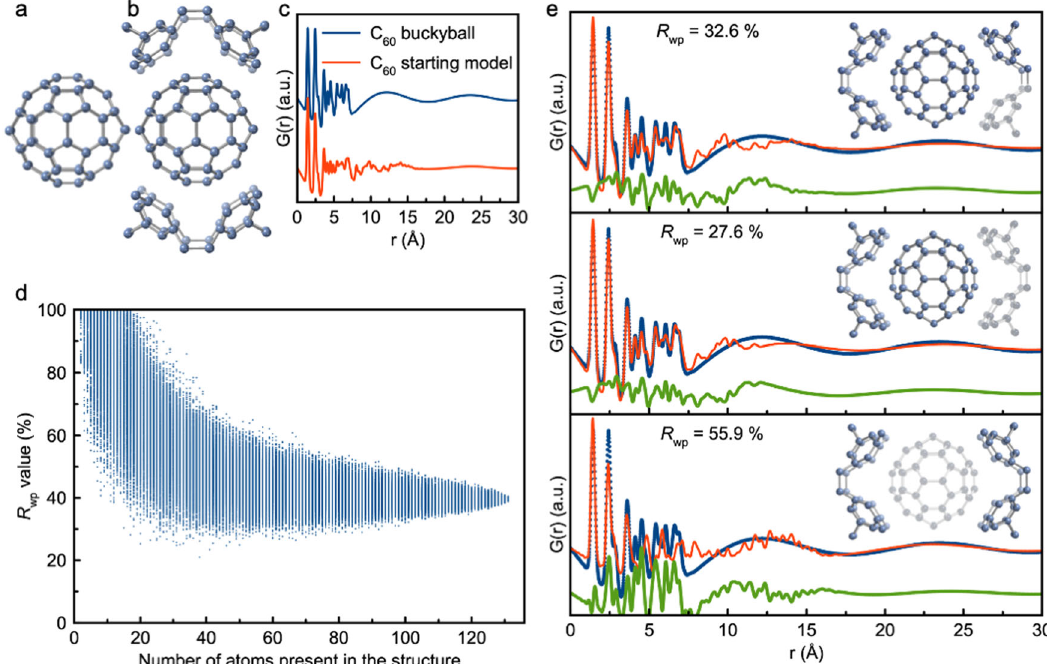
Fig. 3 Analysis of a simulated PDF from a C 60 buckyball. a C 60 buckyball, b single C 60 unit cell 29 , treated as a discrete structure with 132 atoms and c their simulated PDFs. The simulation parameters mimic typical values of a PDF dataset and are presented in Supplementary Table 3. d R wp values obtained in the fi ts using the C 60 structure catalogue, plotted as a function of number of atoms in the structure motifs. Note that the model with a single C 60 buckyball is not included in the set of 384,260 structures tested. This would result in a perfect fi t with R wp = 0%. e Examples of candidate structure motifs with their corresponding fi ts to the simulated C 60 buckyball data. Grey, semitransparent atoms are removed from the starting model.